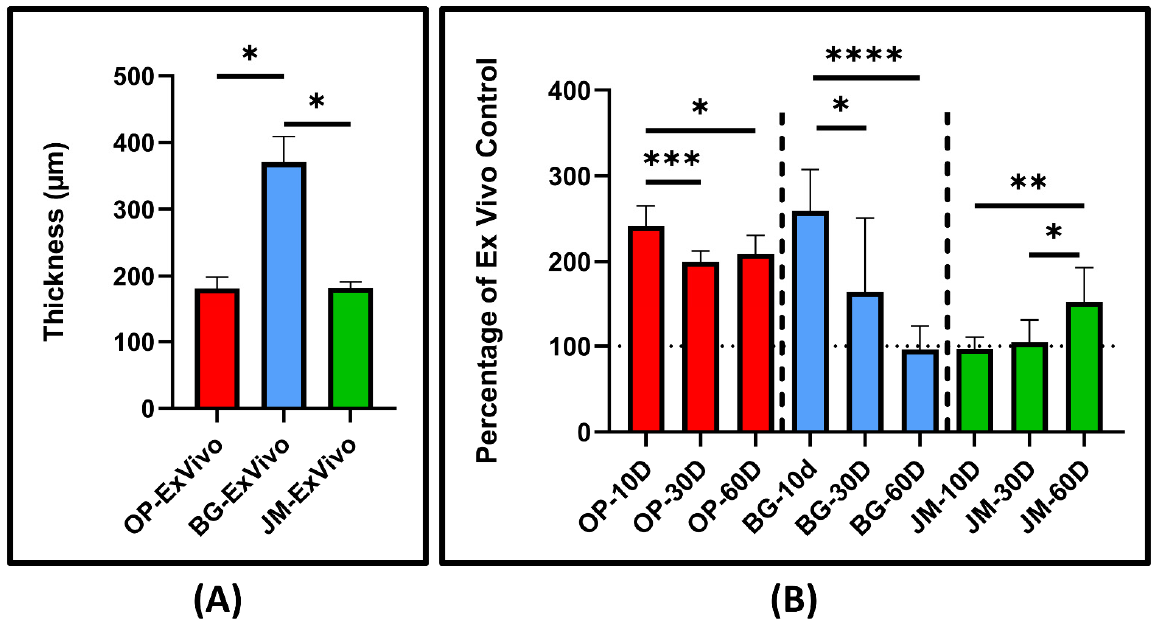
Figure 9. Statistical analysis of the histomorphometrical results of the ex vivo ( A ) and in vivo ( B ) thickness of the barrier membranes (Ossix ® Plus (red), Bio-Gide ® (blue), and Jason ® membrane (green)) at different time points. The measurements are relative percentages of the ex vivo baseline membranes. (* p ≤ 0.05, ** p ≤ 0.01, *** p ≤ 0.001, **** p ≤ 0.0001).